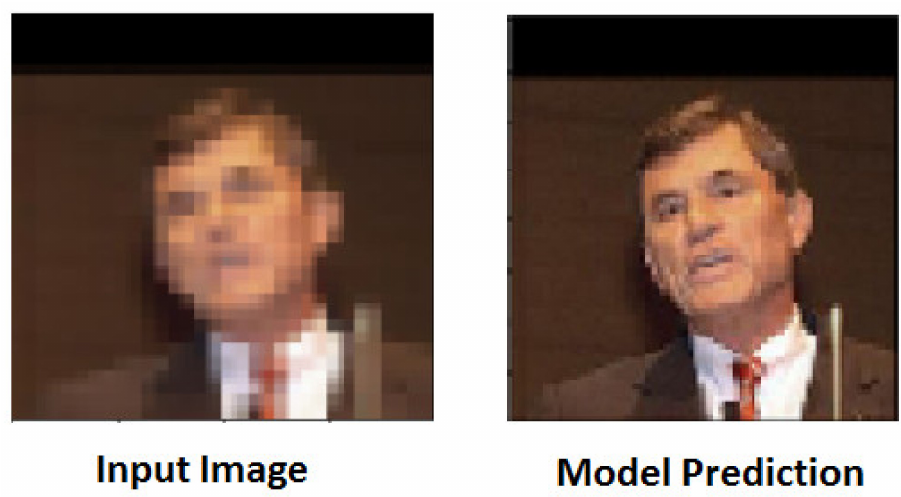
Figure 13. Convolutional Autoencoder Input and Prediction (LFW Dataset).